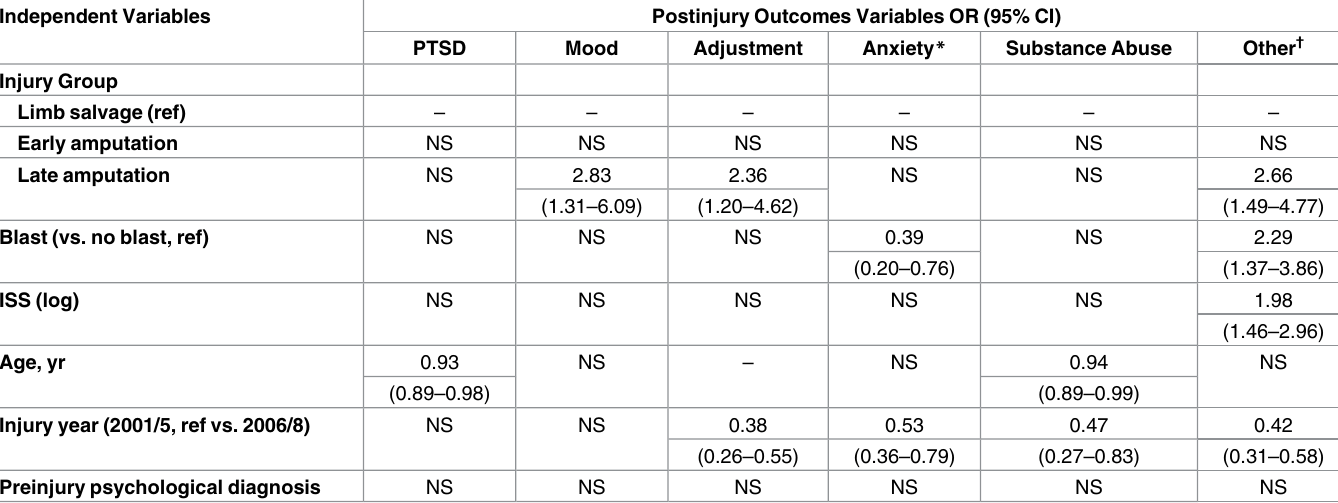
Table 4. SummaryResults for Overall (4 Year) Regression Models for Psychological